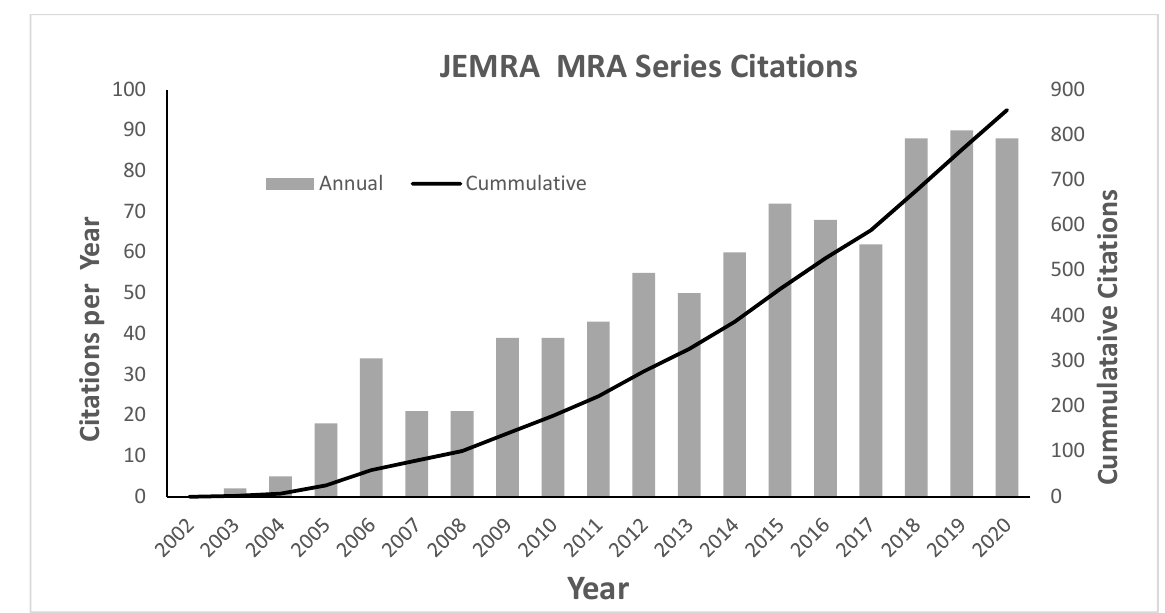
Figure 3. Citations of JMRA MRA publications as indexed by Web of Science (retrieved 15 June 2021).